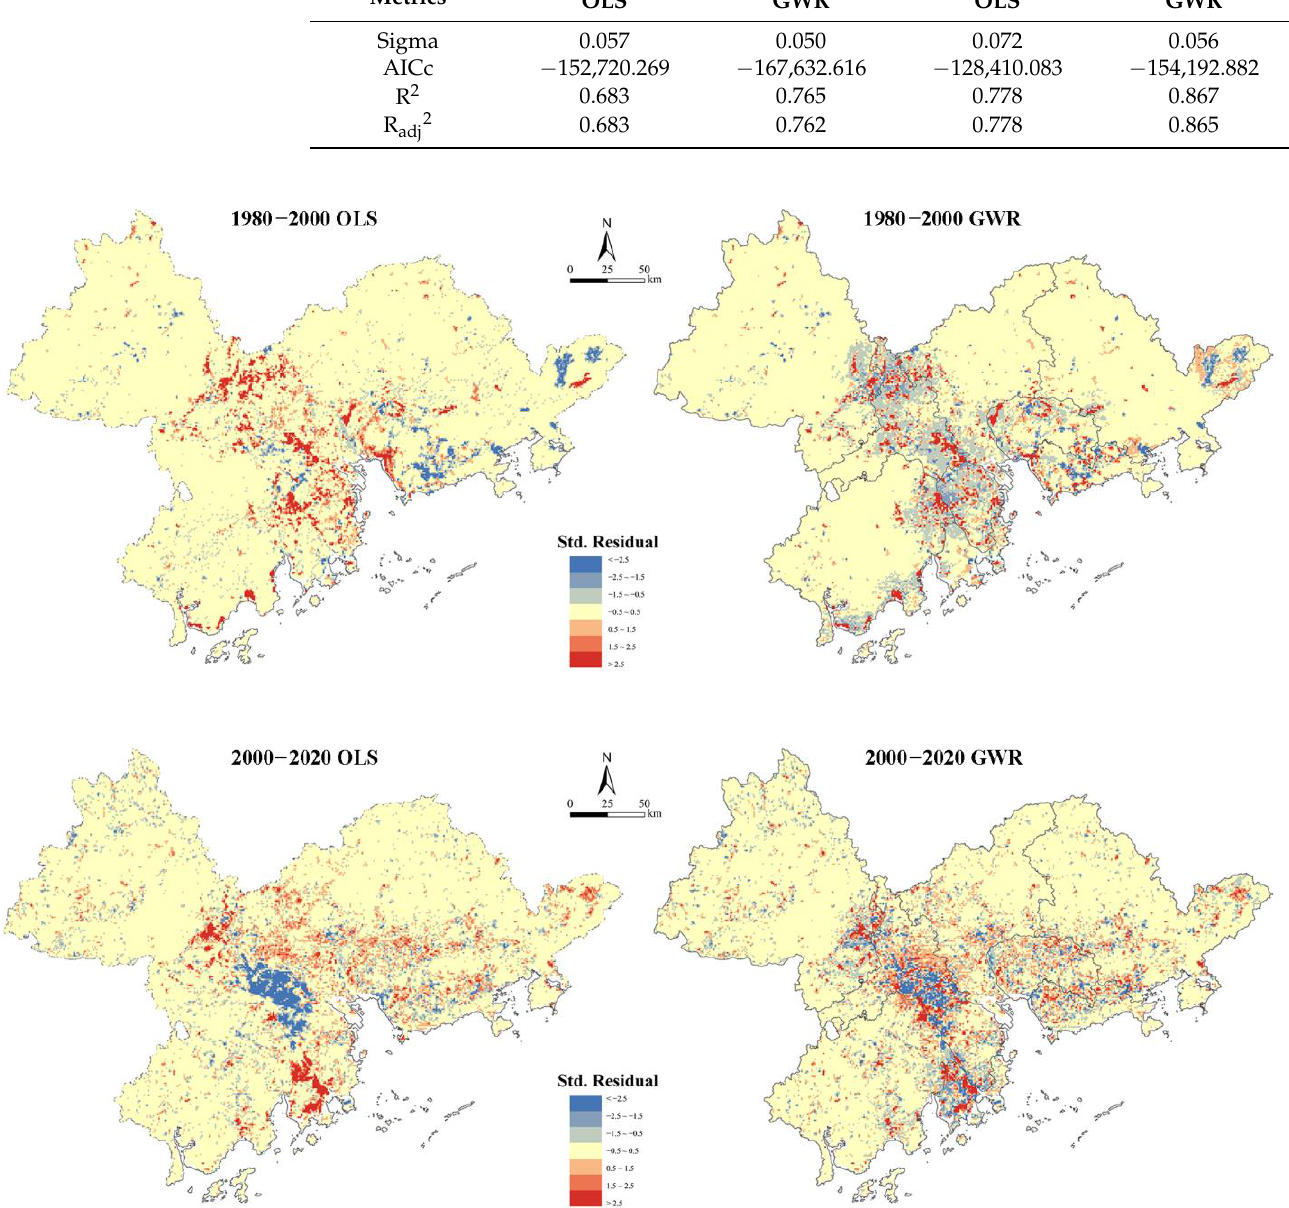
Figure 4. Standard residual results of the OLS model and GWR model.